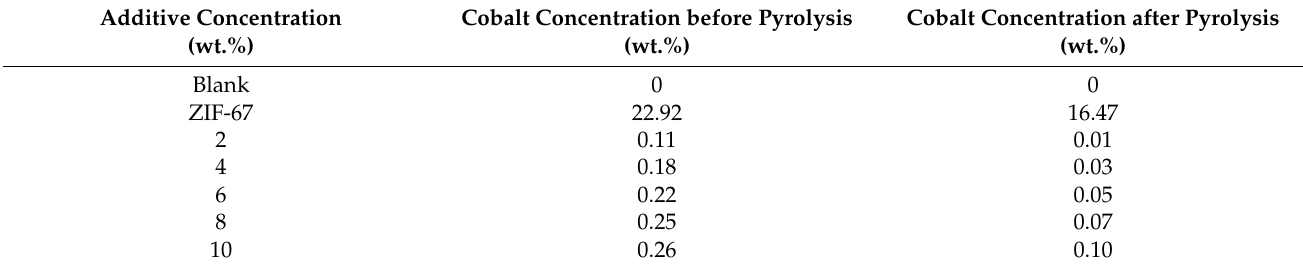
Table 2. The concentration of cobalt in ZIF-67 and pyrolyzed ZIF-67 PVA/starch nanocomposite membranes. Additive Concentration